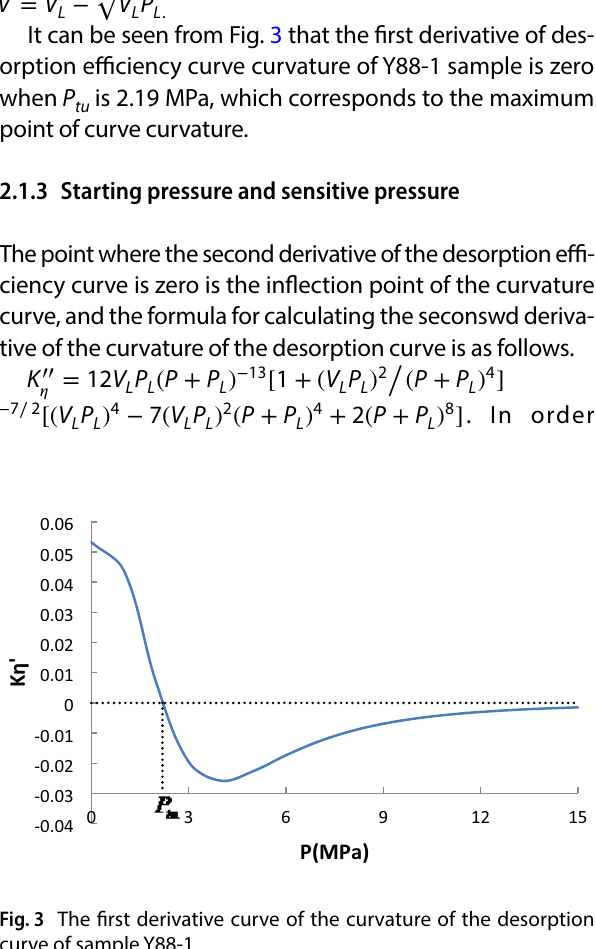
Fig. 2 Desorption curve curvature curve of Y88-1 sample